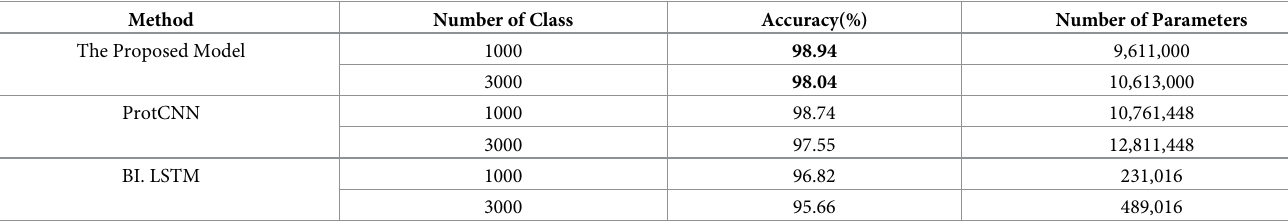
Table 5. Parameter comparison with ProtCNN and bi-directional